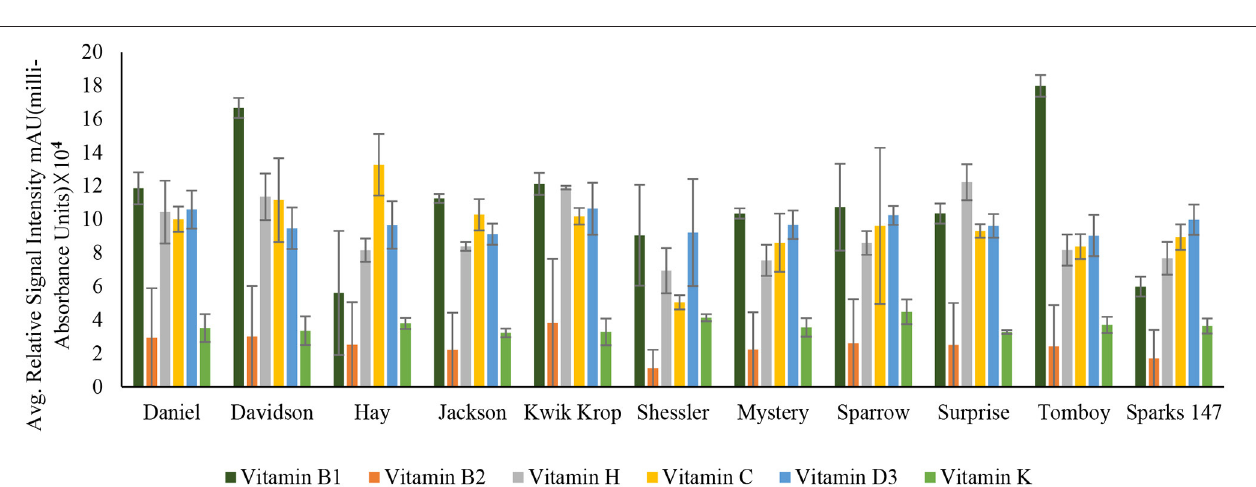
(44). Black walnut protein powder contains higher amount of nitrogen which is 96.6 mg/g compared to black walnut kernel 43.5 mg/g and Persian walnut 27.6 mg/g,